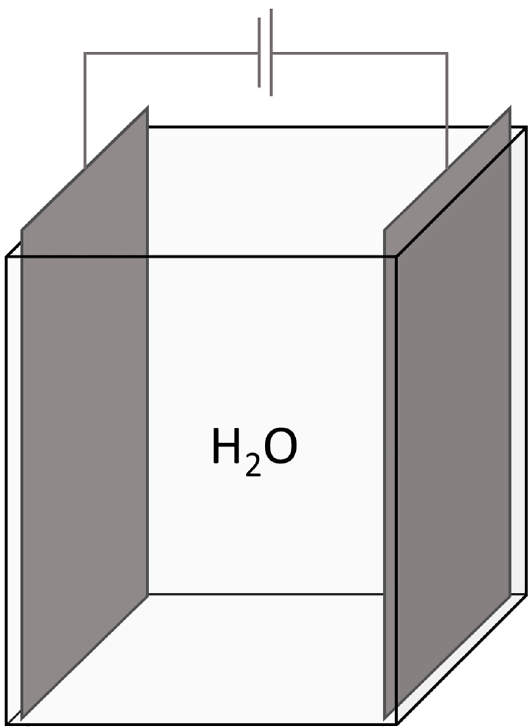
Figure 1. Scheme of the experimental setup used in impedance spectroscopy analysis of